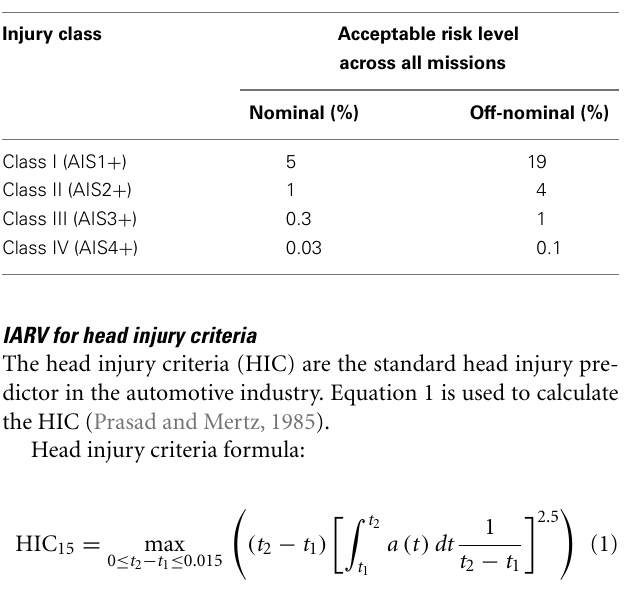
Table 5 | Injury classification mapping and acceptable risk